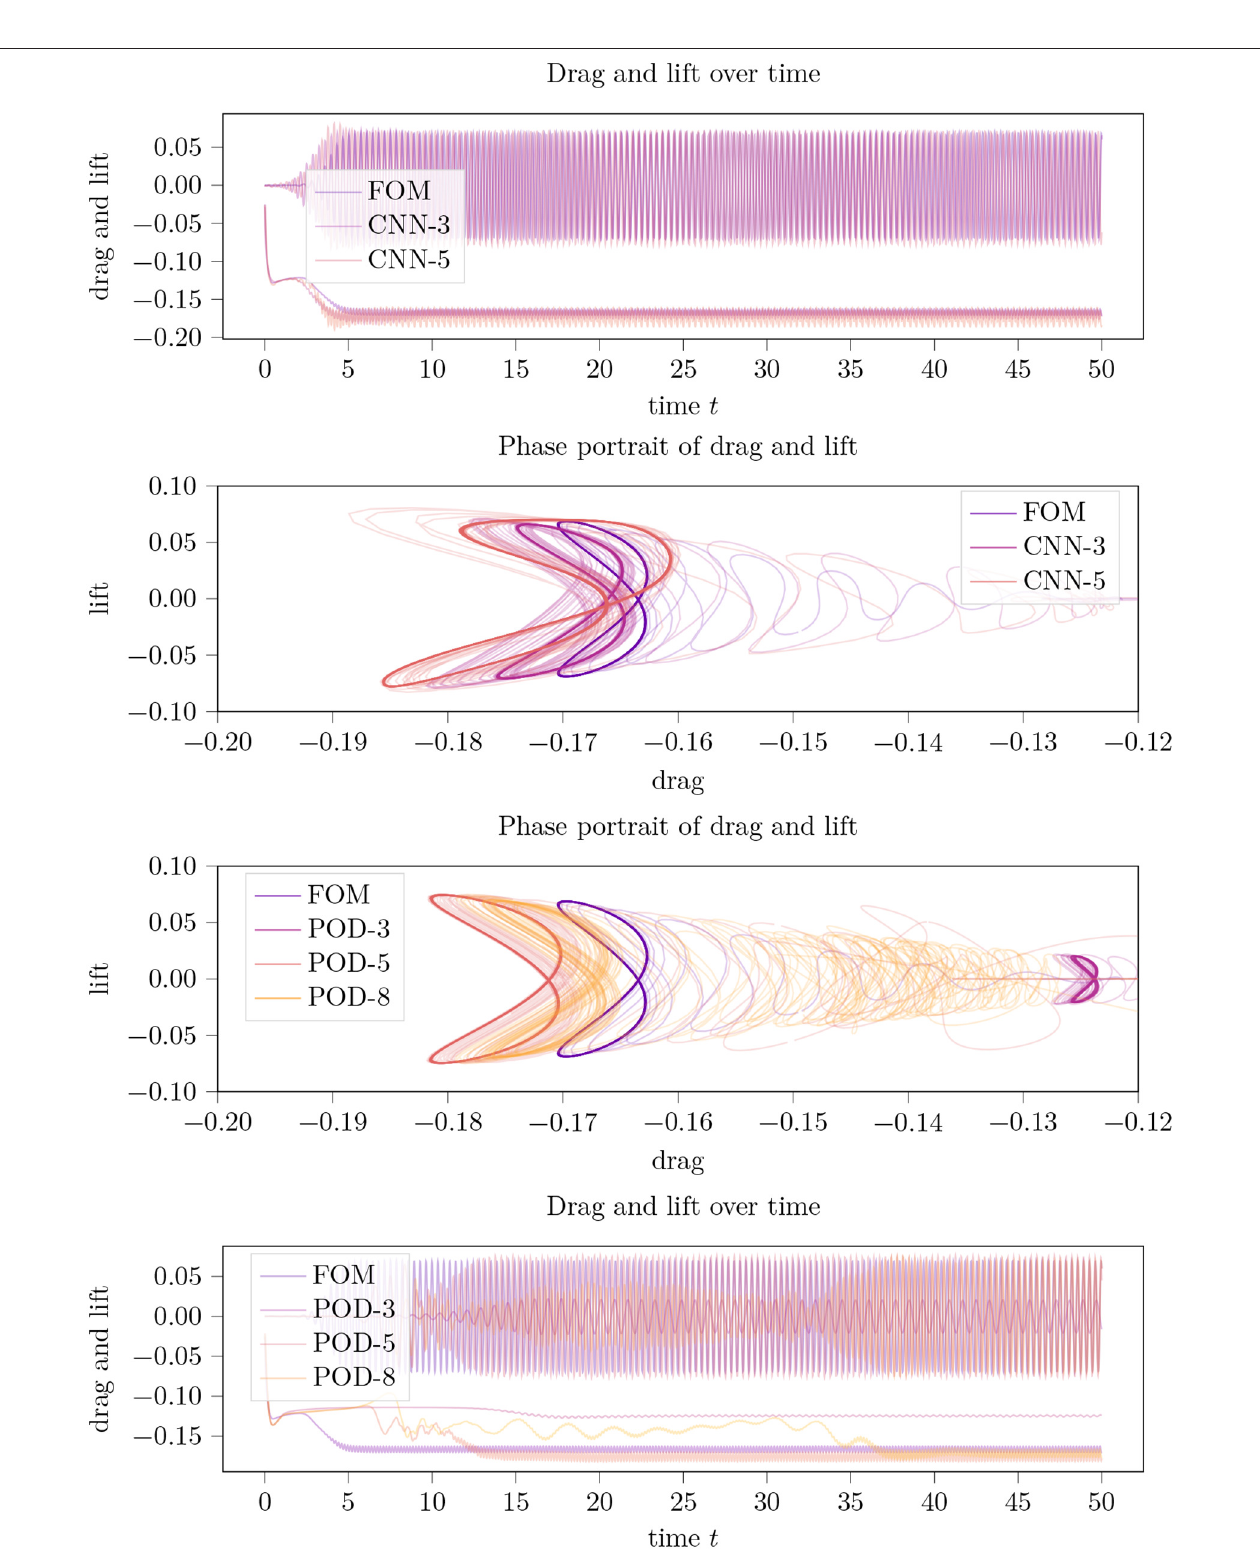
FIGURE 7 | Summarized results for the case of Re = 60. Drag and lift trajectories over time and their phase portraits for an LPV approximation of the incompressible flow around a 2D cylinder using a variable parameter dimension cs in the POD and CAE approximation and in comparison to the full order model (FOM).